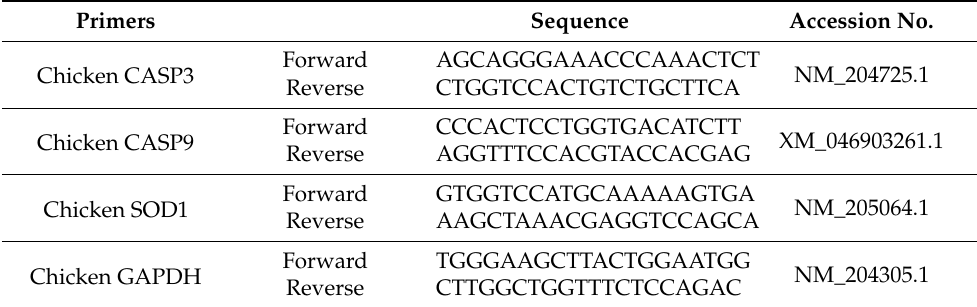
Table 1. Primers for quantitative reverse transcription PCR